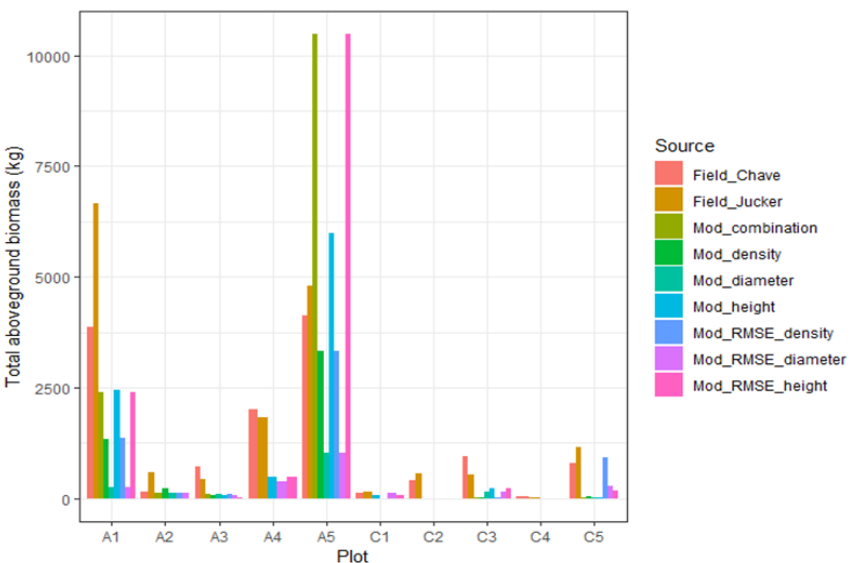
Figure 8. Comparison of total aboveground biomass for plots obtained from different equations and parameter-combination selection criteria. Field_Chave = biomass estimated from field measurements using Equation (2); Field_Jucker = biomass estimated from field measurements using Equation (3); Mod_combination = PC classification and individual tree-detection parameters described in Table 5; Mod_density = PC classification and individual tree-detection parameter combination for tree density; Mod_diameter = PC classification and individual tree-detection parameter combination for crown diameter; Mod_height = PC classification and individual tree-detection parameter combination for tree height; Mod_RMSE_density = PC classification and individual tree-detection parameter combination that presented the lowest density difference for tree density; Mod_RMSE_diameter = PC classification and individual tree-detection parameter